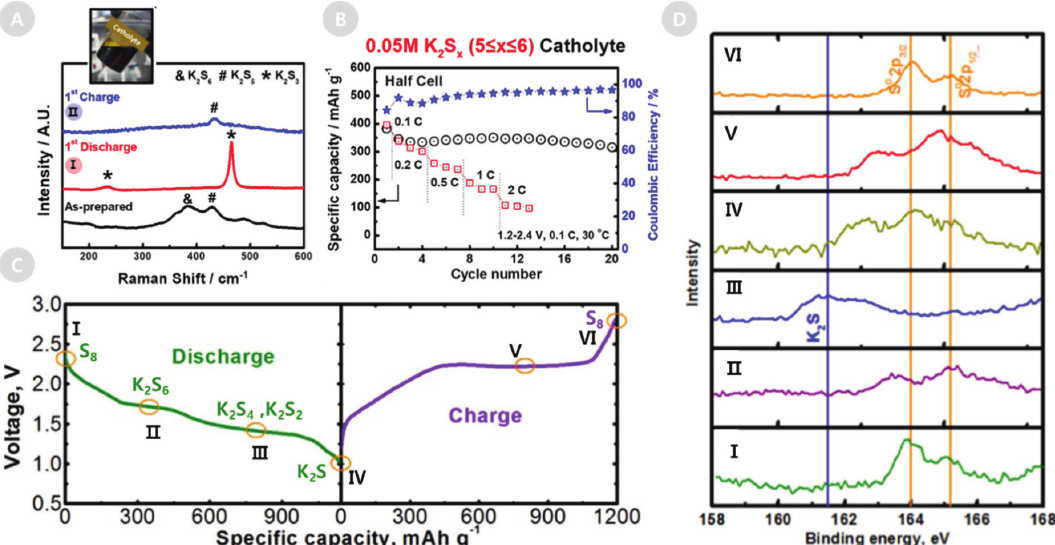
Figure 3. ( A ) Digital photograph of as-prepared K 2 S x (5 ≤ x ≤ 6) catholyte and Raman spectra at different state-of-charge (SOC) (black line: as-prepared; red line: discharge state at 1.8 V; blue line: charge state at 2.4 V). Figure adapted from Reference [9]. ( B ) Cycling and rate performance of a K || K 2 S x (5 ≤ x ≤ 6) catholyte || three-dimensional freestanding carbon nanotube (3D-FCN) cell. Figure adapted from Reference [9]. ( C ) Specific discharge–charge states in a voltage profile of the K || Celgard / SWCNT || S / CNF cell, from which samples were collected for XPS analysis. Figure adapted from Reference [8]. ( D ) XPS S 2p spectra of S electrodes being discharged or charged to different states in the K || Celgard / SWCNT || S / CNF cells. Figure adapted from Reference